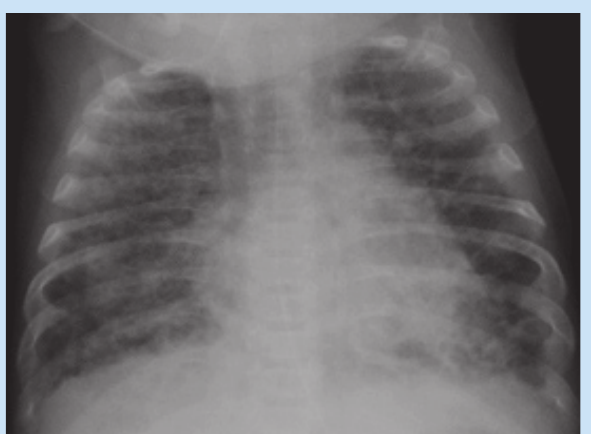
Fig. 12. Complications of ventilation. After chronic ventilation on oxygen, this patient has developed changes compatible with chronic lung disease, namely heterogeneously distributed areas of collapse and air-trapping, resulting in a coarse